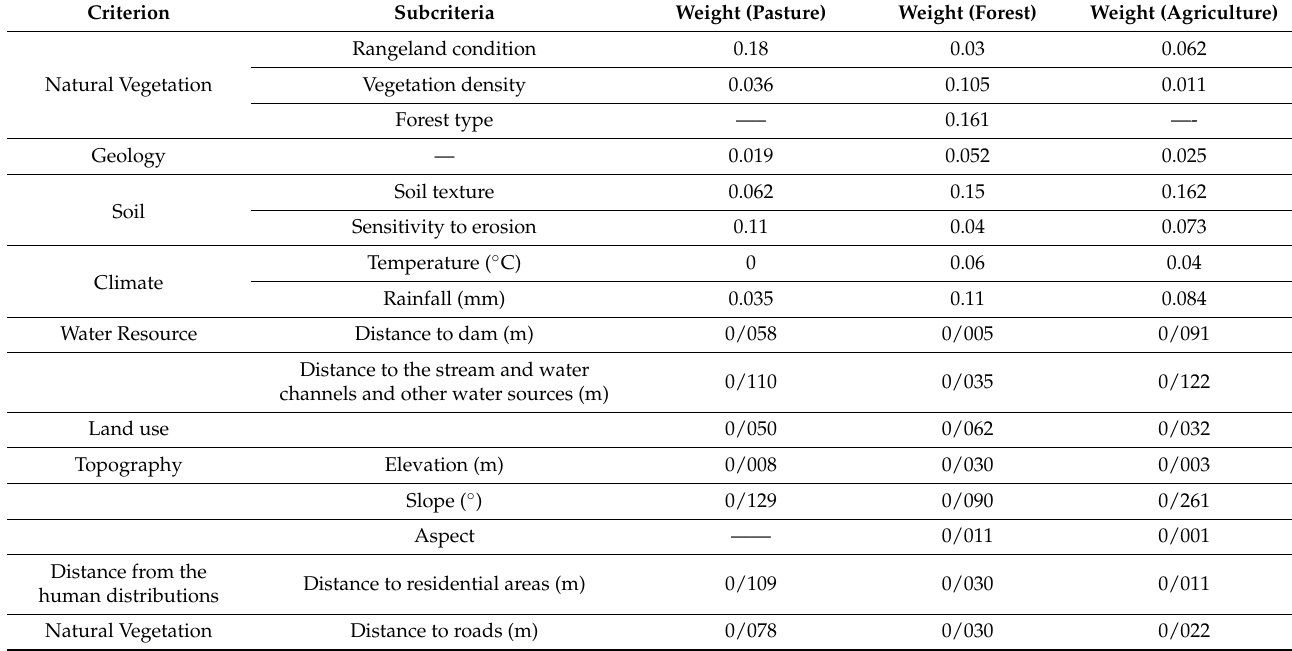
Table 1. Relative weights of criteria/factors used in future land use planning under the conservation scenario. Criterion Subcriteria Weight (Pasture) Weight (Forest) Weight (Agriculture) Natural